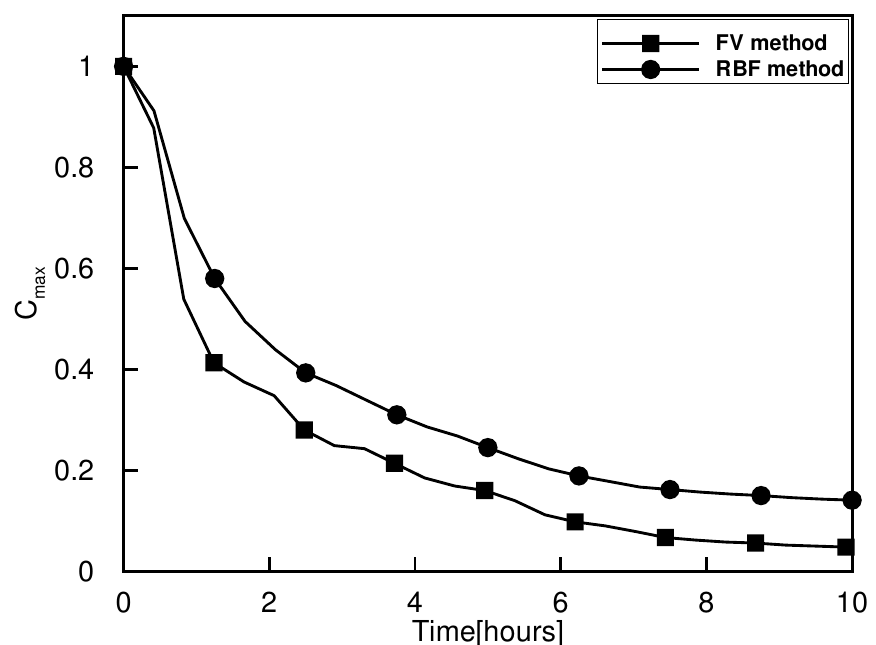
Figure 10. Evolution of the maximum pollutant concentration against